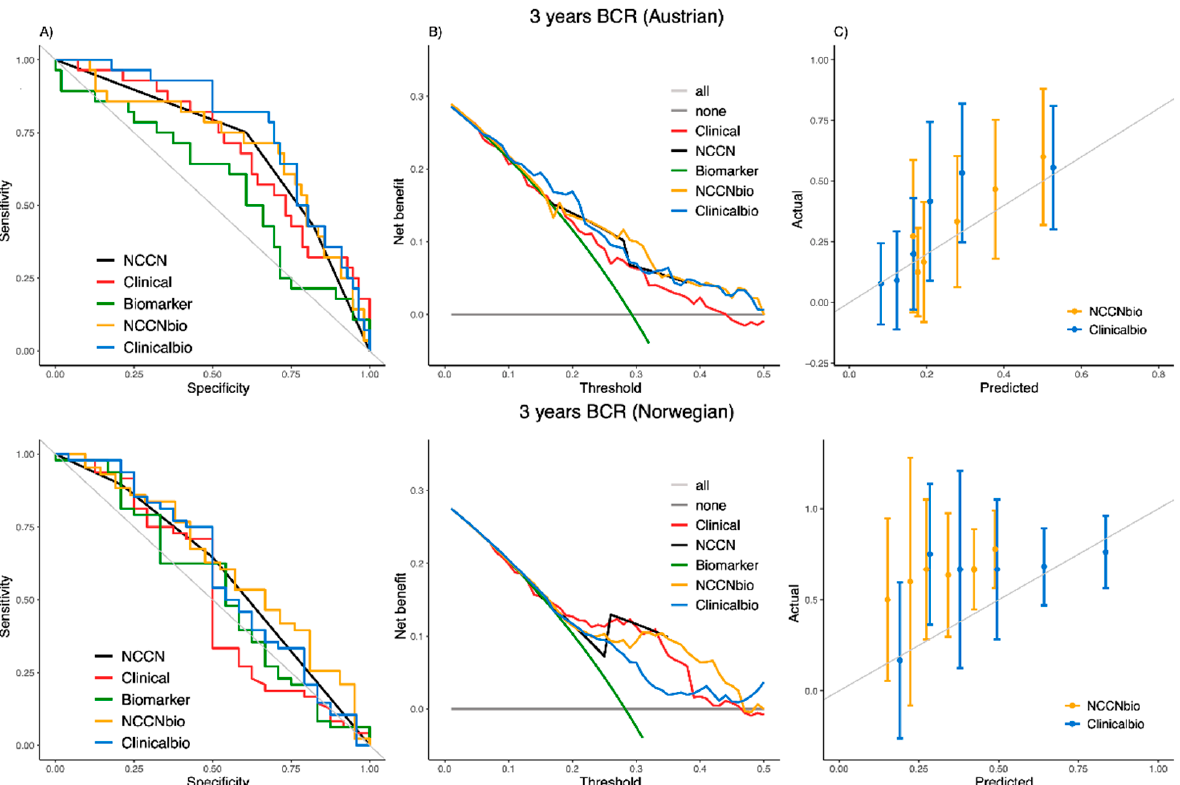
Figure 2. ROC curve ( A ), decision curve ( B ) and calibration plot ( C ) of the ‘NCCNbio’ and ‘Clinicalbio’ models externally compared with ‘NCCN’, ‘Clinical’ and ‘Biomarker’ models in independent Austrian (on the top) and Norwegian (on the bottom) cohorts at 3